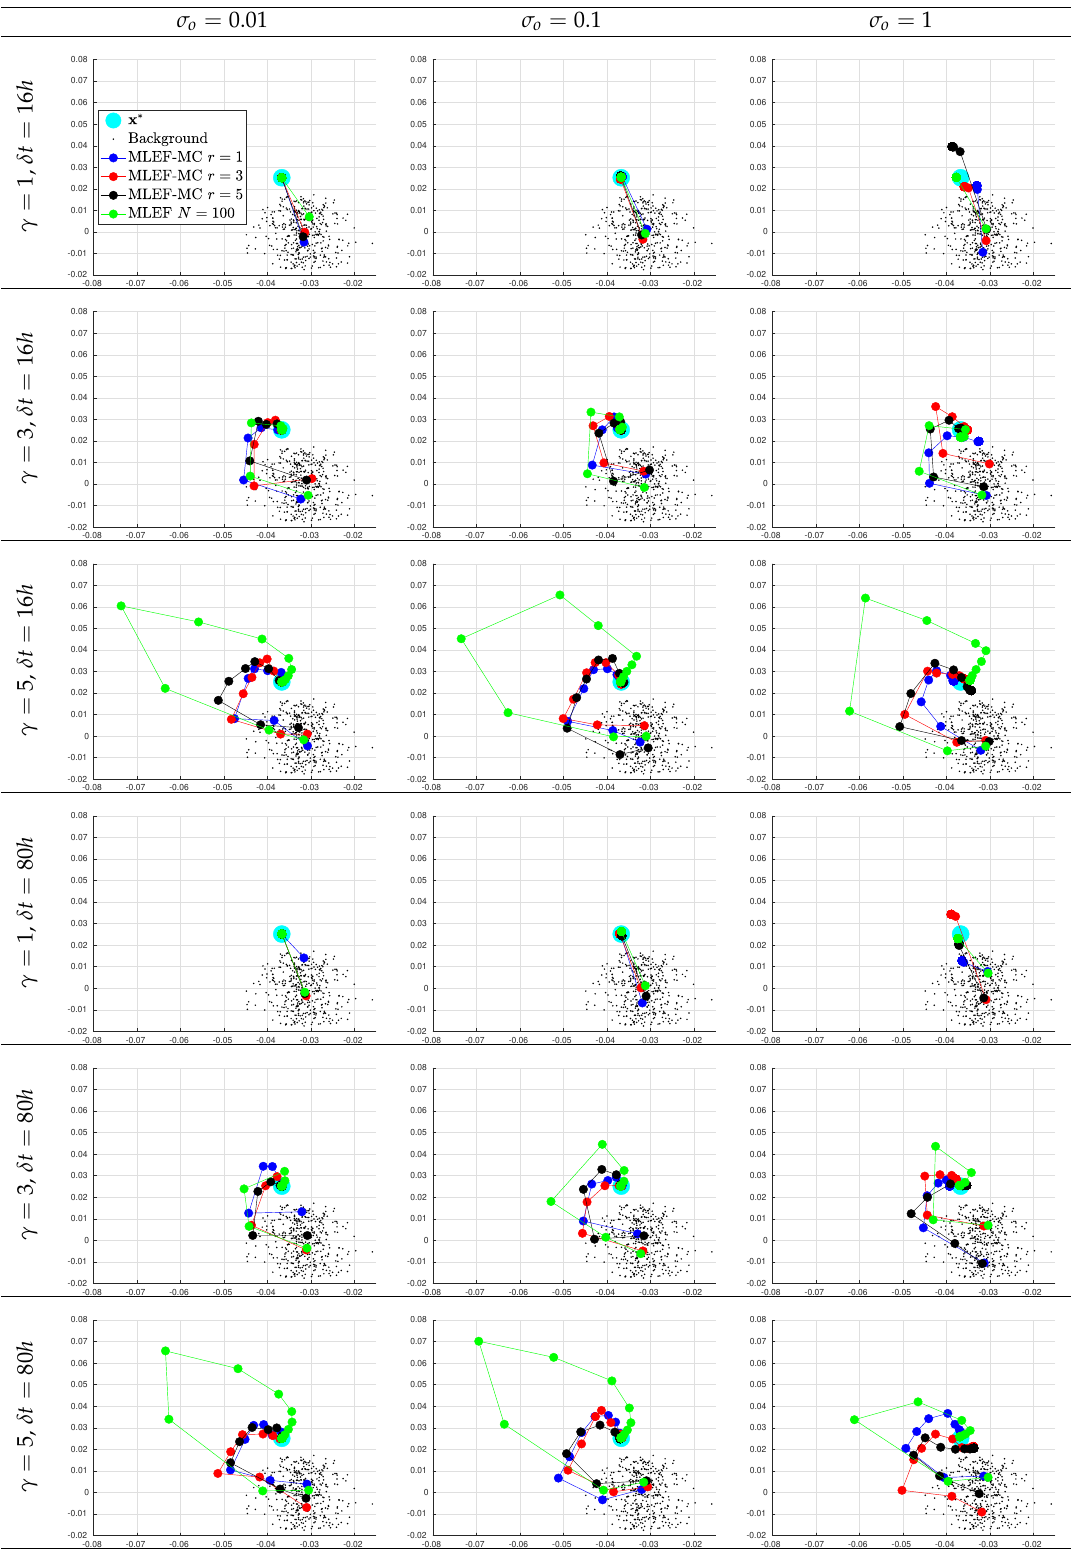
Figure 7. Snapshots of iterates for the initial analysis step. Different time frequencies of observations were employed during the experiments. The percentage of observations from the model state reads s =